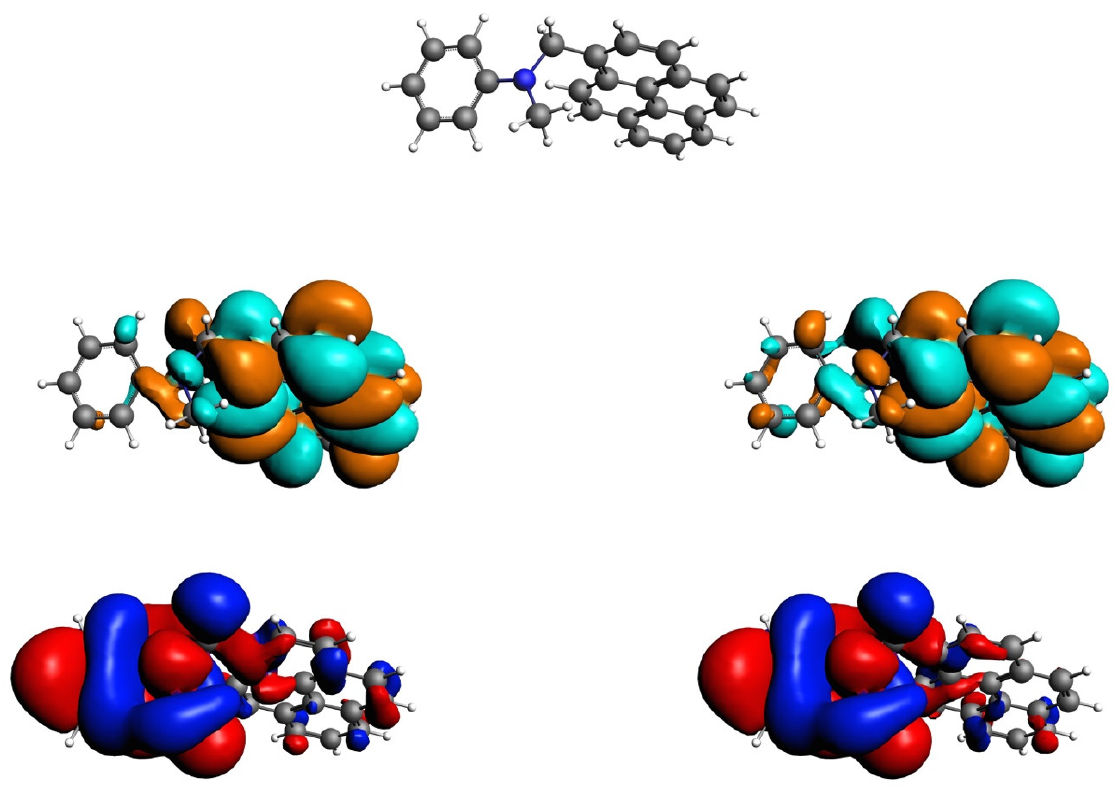
Figure 7. The natural transition orbitals (HONTOs, bottom and LUNTOs, middle ) for the singlet 1 CT ( left ) and triplet 3 CT ( right ) charge transfer states at an iso-value of 0.01; (PBE/TZ2P), SS NTO-1, 2.867 eV, S 1 = 1 CT and ST NTO-1, 2.854 eV, T 2 = 3 CT. The molecular structure, at the same view, is presented at the top. Slight differences can be seen in the orbital extensions to the other unit.